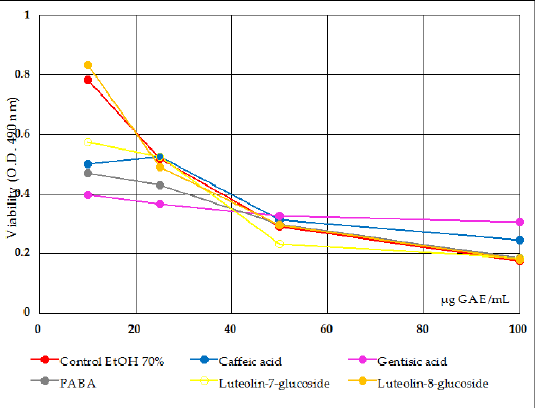
Figure 4. Caco-2 antiproliferative activity of the five reference compounds (phenolics), at 48 h.